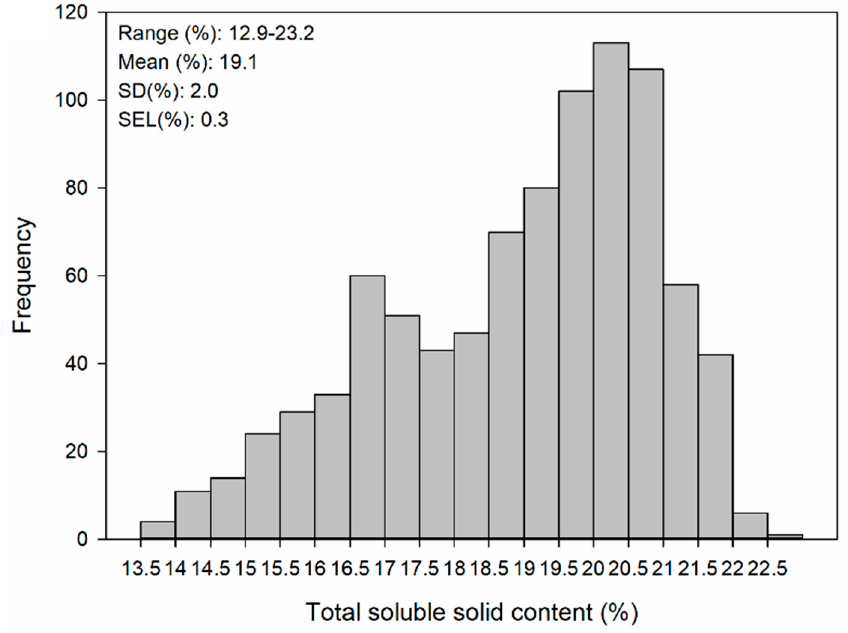
Figure 1. Distributions of total soluble solid contents in single grape berries for Ruby Seedless with range, mean value, and standard deviation (SD) .